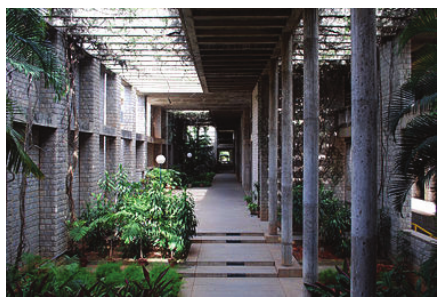
Figure 2. IIM Bangalore, Pedestrian Pathways Figure 3. Aranya Low Cost Housing,